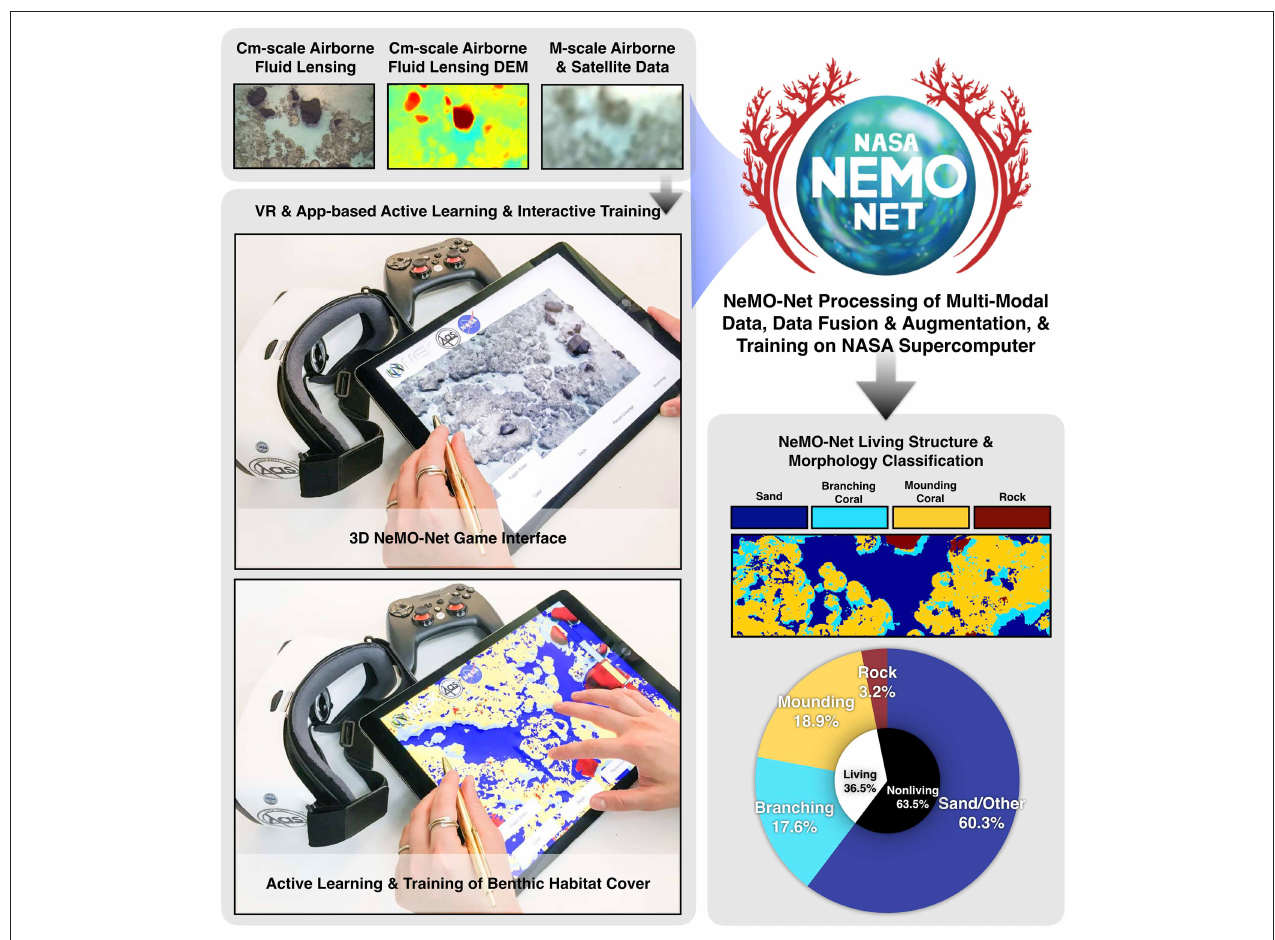
FIGURE 13 | NeMO-Net is aimed at harmonizing the growing diversity of remote sensing and in situ imagery into a single open-source platform for assessing shallow marine ecosystems at scale across the globe. An active learning game, playable on tablet and virtual reality platforms, allows users to view 3D FluidCam data of coral reefs and provide training data on coral classes including living cover, morphology type, and family identification. These data, along with their spatial coordinates, are fed into NeMO-Net, which produces a classification map and reef constituent breakdown as well as error analysis based upon training data. This technology is presently under development and will be expanded to third-party georeferenced 3D datasets as